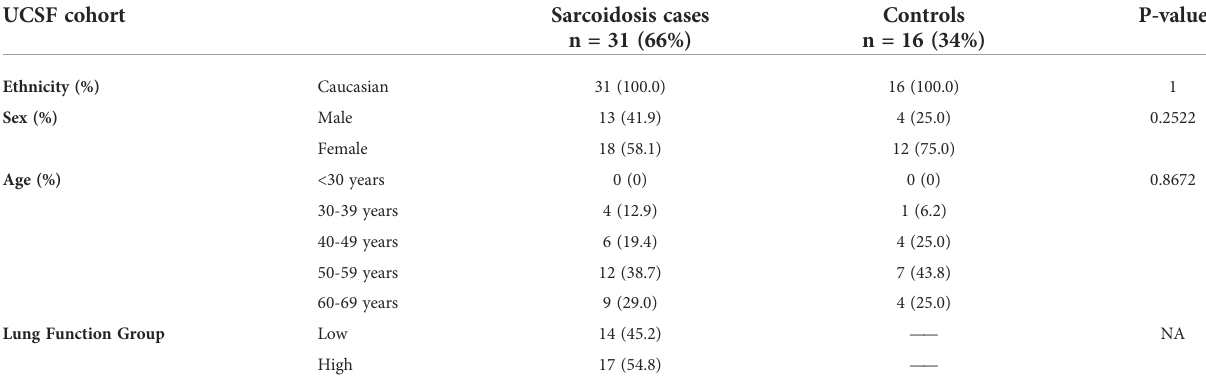
TABLE 2 Baseline characteristics of sarcoidosis cases and controls from the “ UCSF Sarcoidosis and Hypersensitivity Pneumonitis Cohort ” (GSE19314) based on publicly available information in the gene expression omnibus (GEO) database. UCSF cohort